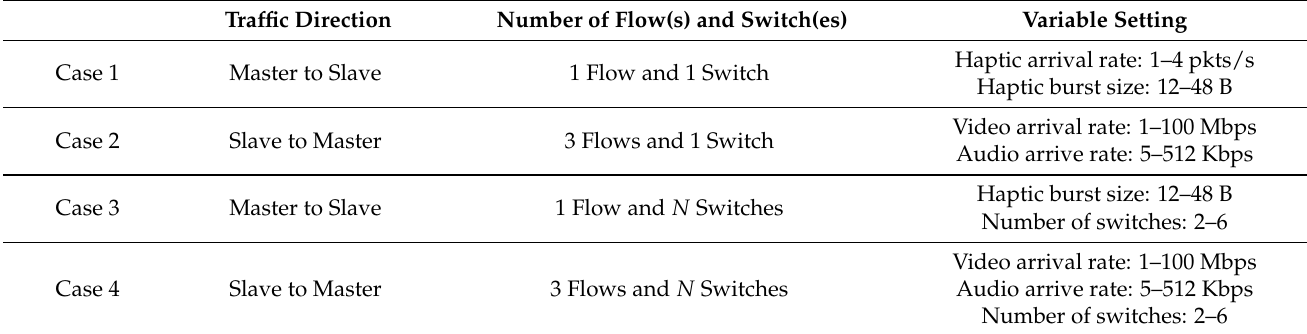
Table 1. Actual situations and parameter Settings in four